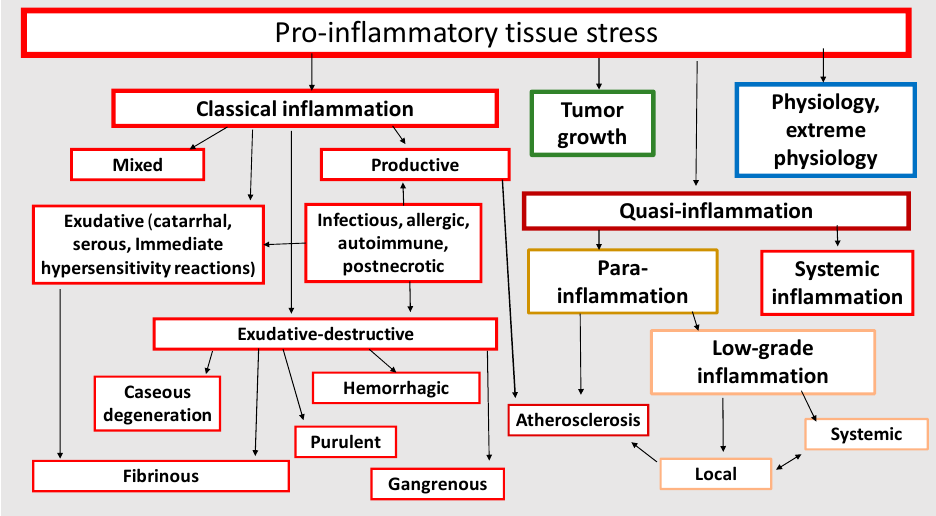
Figure 6. Pro-inflammatory tissue stress as a common basis for the development of general pathological and some physiological processes.